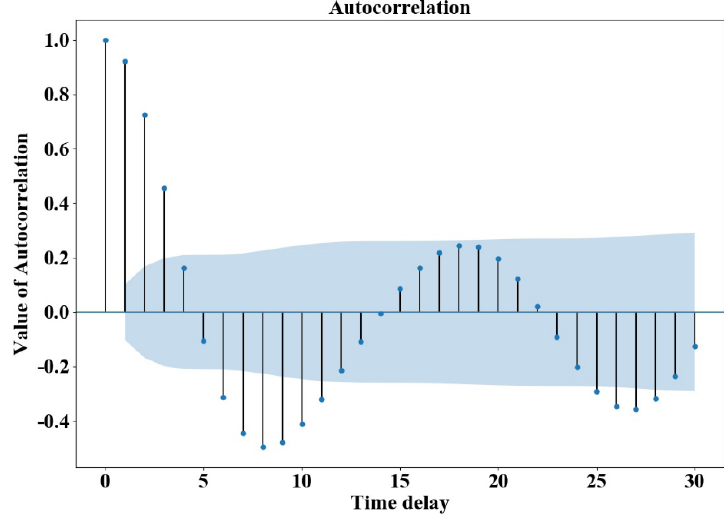
Figure 7. Autocorrelation chart of water consumption difference at the monitoring point 1. Table 3. The unit root test results of the water consumption data difference at monitoring point 1.